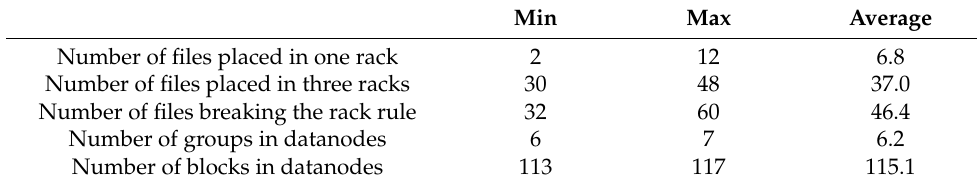
Table 1. Statistical information of 3D raster data distribution in ten